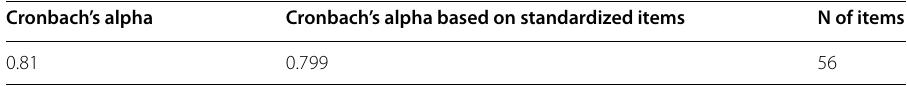
Table 1 The reliablity statistics for the questionnaire Cronbach’s alpha